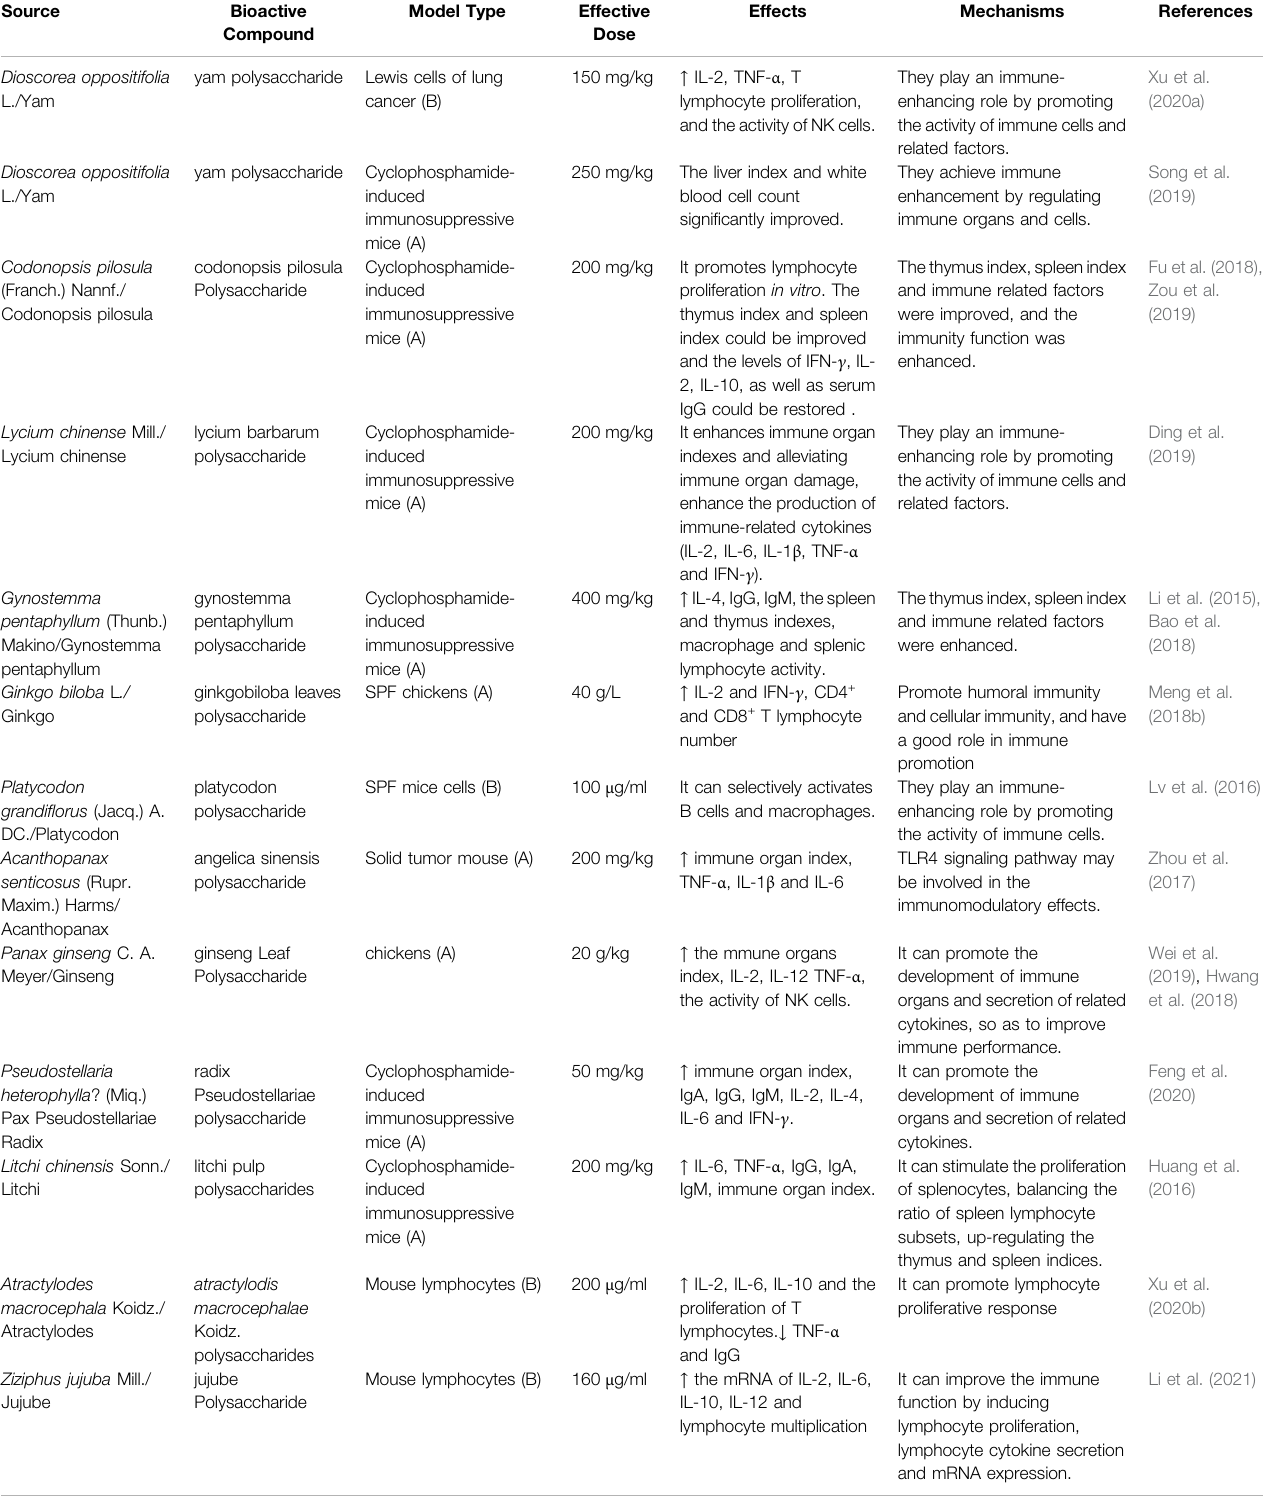
TABLE 1 | Experiment and mechanism of polysaccharides bioactive components from plant-based functional foods on immune